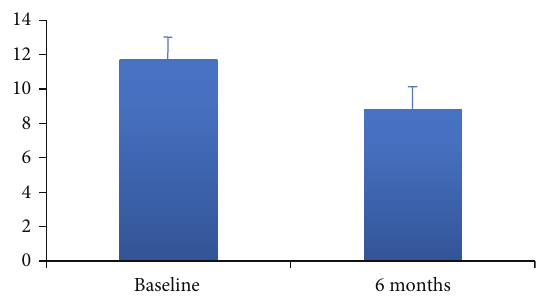
Figure 2: Acid exposure (% pH < 4.0 ) before and after